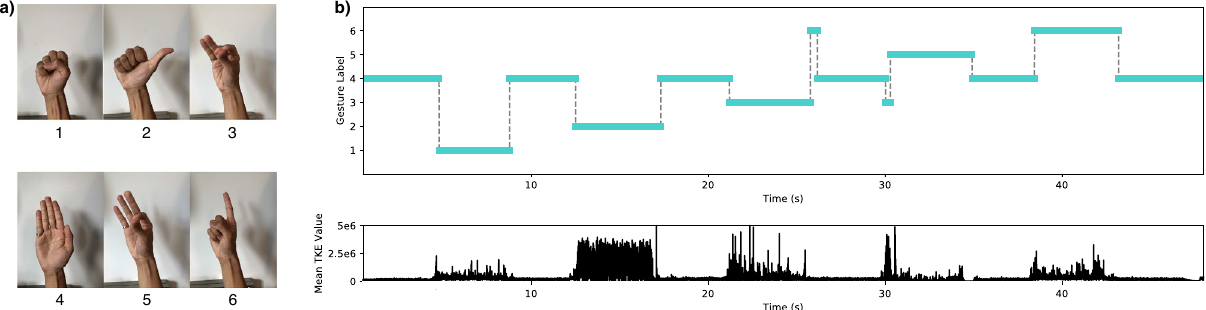
Figure 3. Real-Time Classification. ( a ) Set of 6 functional hand postures/grip modes: (1) closed hand/fist, (2) thumb-up and hook grip, (3) tripod pinch, (4) open hand/neutral position, (5) fine pinch, and (6) pointed index. ( b ) Time-distributed system outputs during a real-time inference test performed by user 3. The user cycles through every gesture, holding them for a few seconds and resting in the neutral position (label 4) in between. The top plot shows the system’s predictions (neural network + majority vote). The bottom plot displays the aligned mean Teager-Kaiser Energy (TKE) value to give an idea of the system’s responsiveness to the muscle Figure 2a,b illustrates the user’s involvement in the control loop. Two scenarios are depicted: offline and online. First of all, the neural network must be trained. This step is executed offline as the user records the data